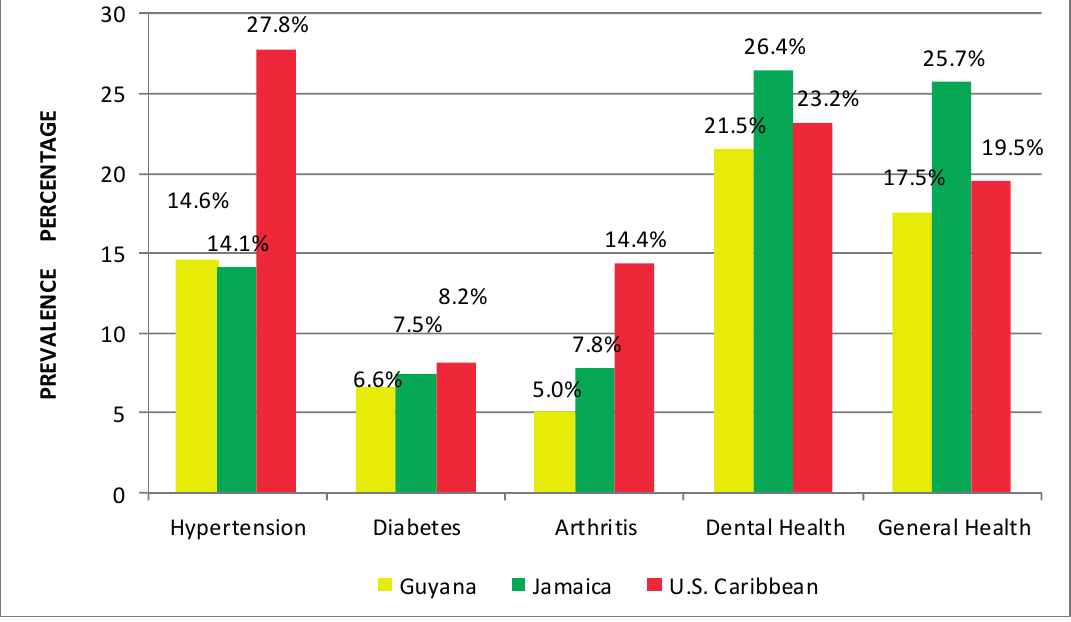
Figure 2. Lifetime prevalence of physical health by